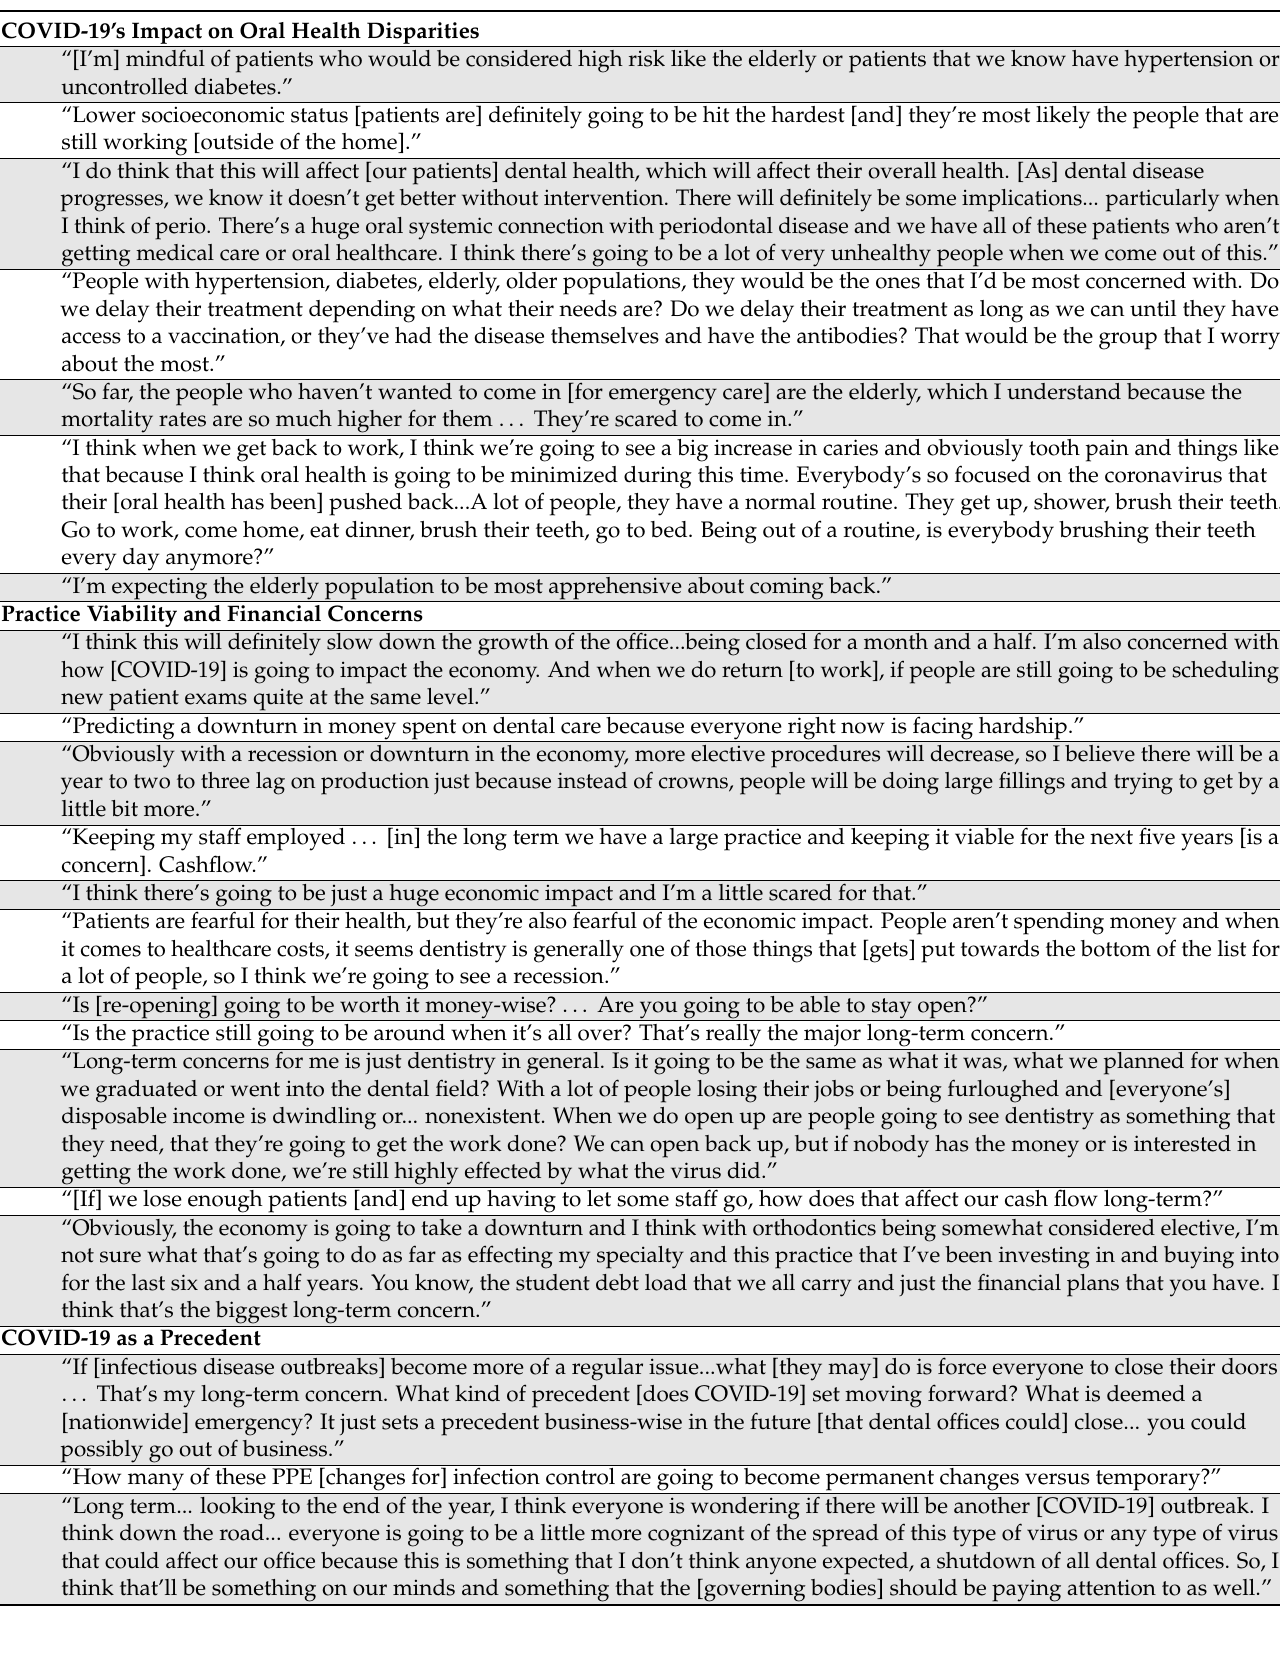
Table 3. Long-term concerns regarding